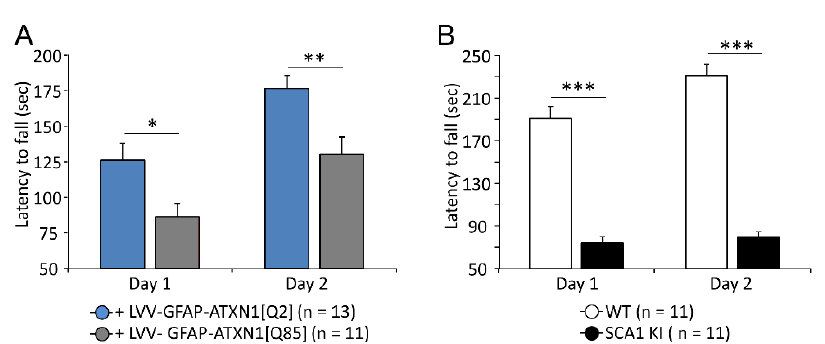
Figure 1. Rotarod performance in two SCA1 models. ( A ) Selective expression of ATXN1[Q85] in BG affected performance of mice on day 1 and 2 but did not prevent the improvement on day 2. ( B ) SCA1 KI mice performed poorly on day 1 and did not improve on day 2. The number of mice tested is shown in parentheses. Asterisks indicate statistically significant difference compared to controls, calculated using two-way ANOVA; * p < 0.05; ** p < 0.01; *** p < 0.001.